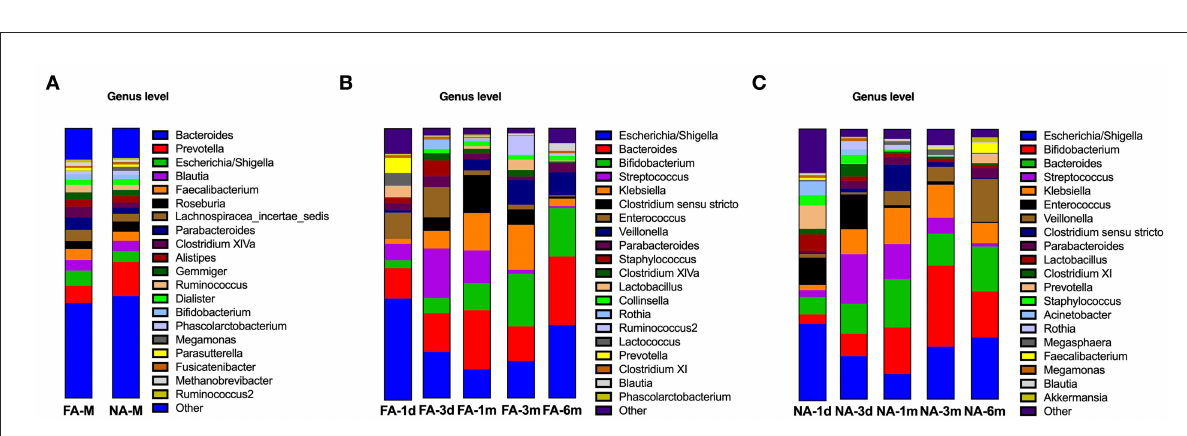
groups. The abundance of Prevotella in the infant gut microbiota was high only on day 1 (FA, 5.58%; NA, 8.62%), low at other periods, and increased again at 6 months in the NA group (3.29%) (Figure